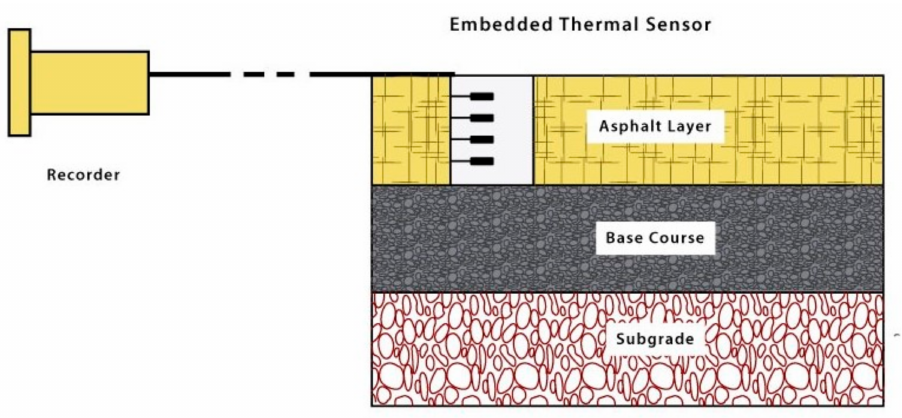
Figure 1. Representation of a pavement temperature measurement